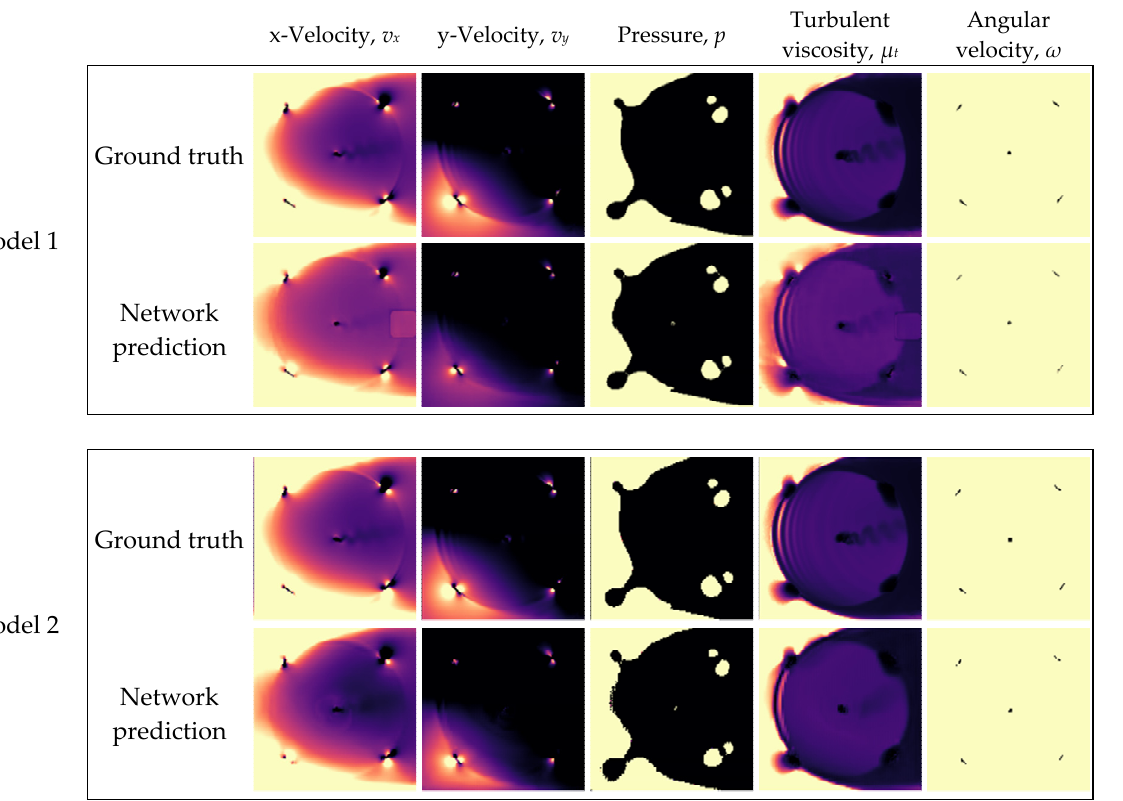
Figure 25. Ground truths and network predictions of Model 1 and Model 2, for the testing case of v ∞ = 2.0 m/s. v ∞ = 2.0 m/s.